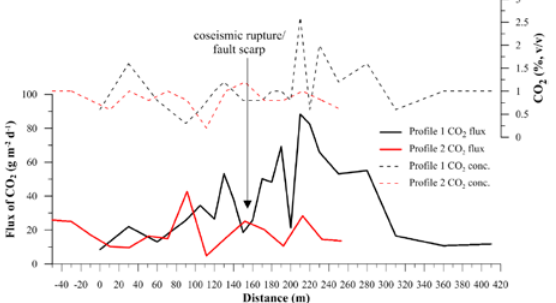
Figure 3. Comparison between the CO 2 flux values and the CO 2 concentrations measured along the two